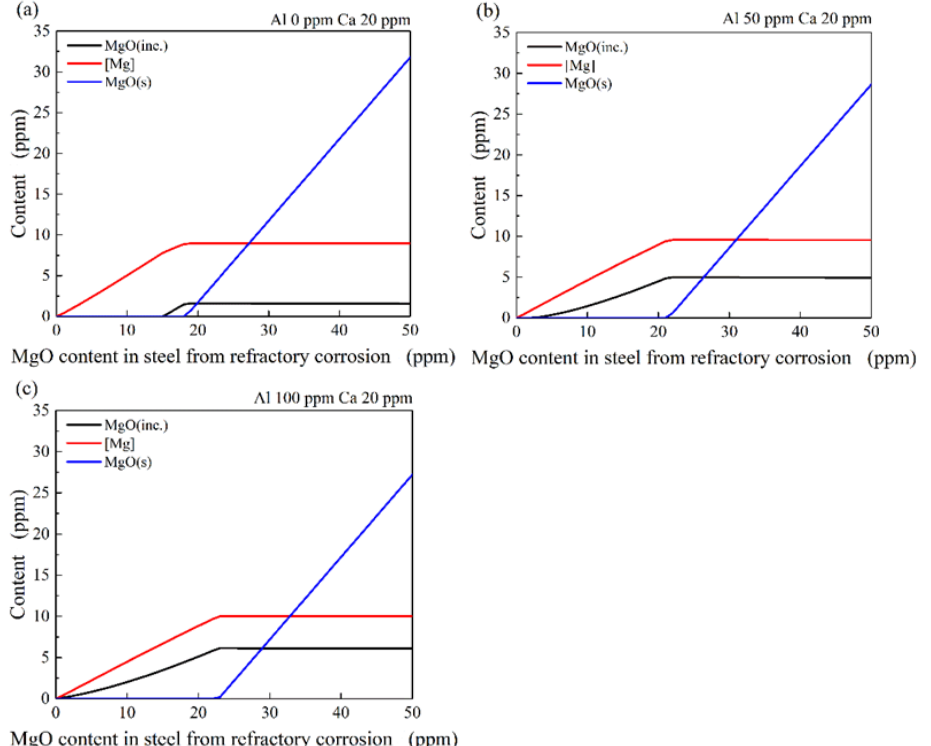
Figure 9. Variations of Mg in molten steel, MgO(inc.) in liquid inclusions, and saturated precipitation of MgO(s) with refractory corrosion. ( a ) [Al] 0 ppm; ( b ) [Al] 50 ppm; ( c ) [Al] 100 ppm. It can be seen that as the MgO content from refractory corrosion increases, the [Mg] firstly increases and then remains unchanged. It shows that the MgO from refractory is reduced to [Mg] because the molten steel contains the strong deoxidization element Ca, as expressed by Equation (5). The [Mg] content remains unchanged until the reaction limit is reached. The change tendency of MgO(inc.) is similar to that of [Mg]. When the contents of MgO(inc.) and [Mg] remain unchanged, the MgO(s) begin to precipitate. It means that as the refractory corrosion aggravates, MgO will no longer exist in the form of spinel or the composite liquid inclusions, but will reach saturation and then precipitate as calcite in the steel. This result is also in agreement with the observed inclusions, which contain different contents of MgO in the experimental samples.